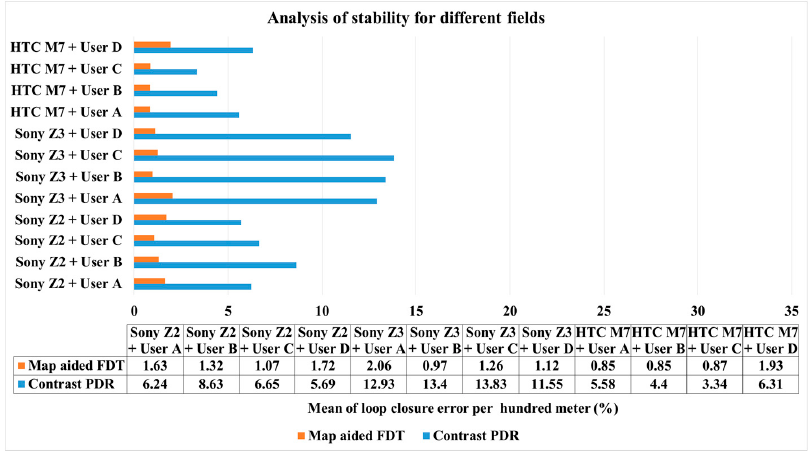
Figure 16. Analysis of stability for different fields.